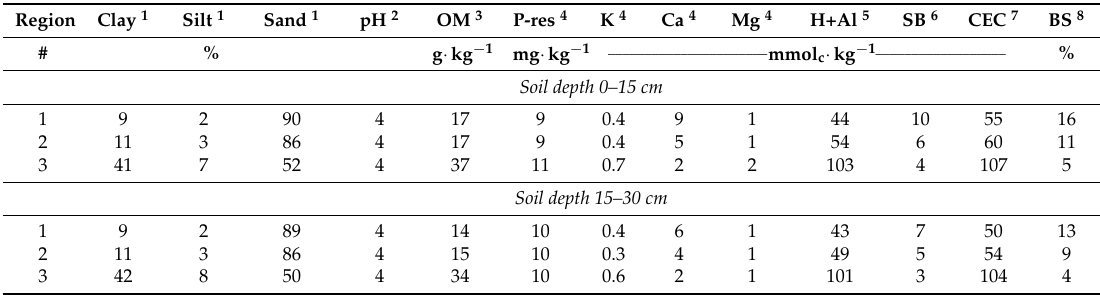
Table 3. Soil physical and chemical properties at the three